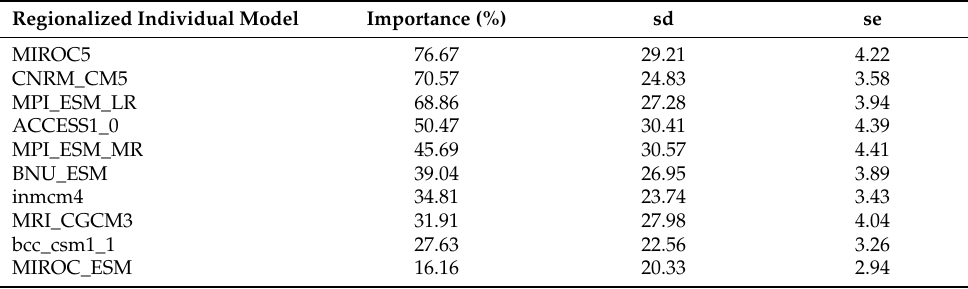
Table A3. Averaged relative variable importance in RF ensembles ( n = 48 weather